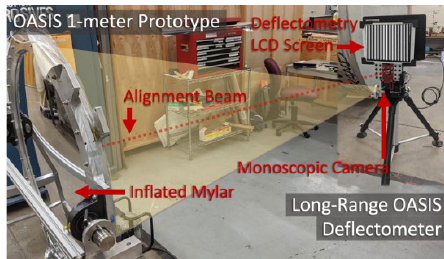
Fig. 3. 1-meter class Mylar OASIS prototype tested using the long-range deflectometry measurement setup (top-right inset).